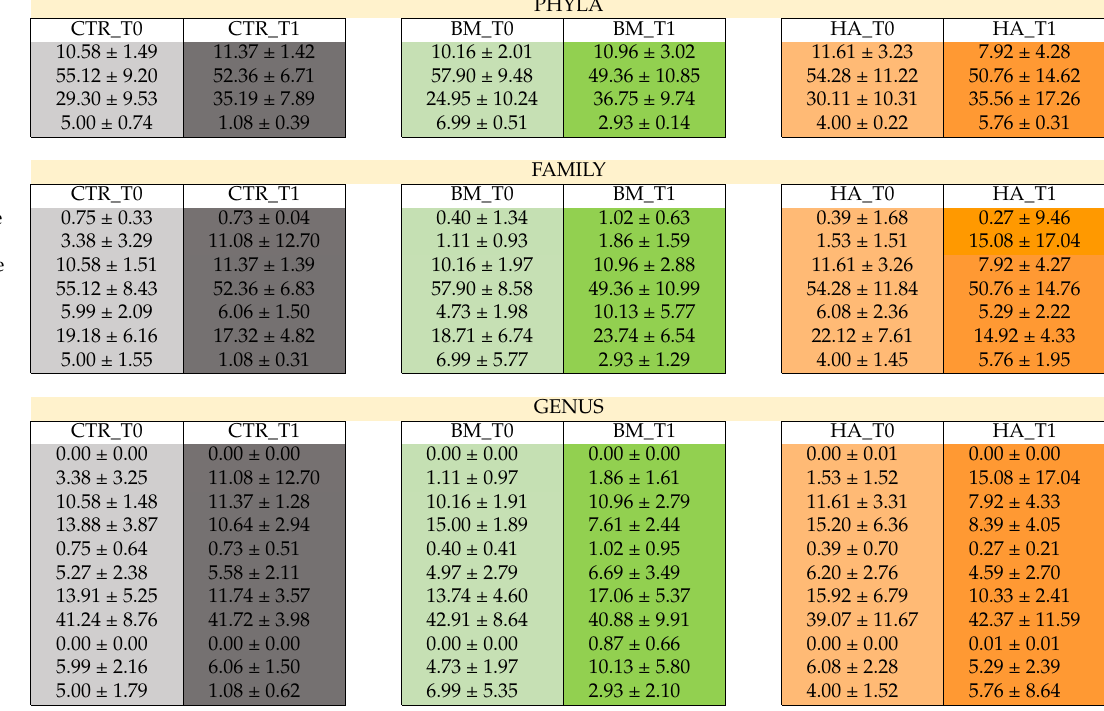
Table 2. Taxonomic assignment. Average values per time and treatment of microbial groups at phyla, family and genus level and related standard deviation.